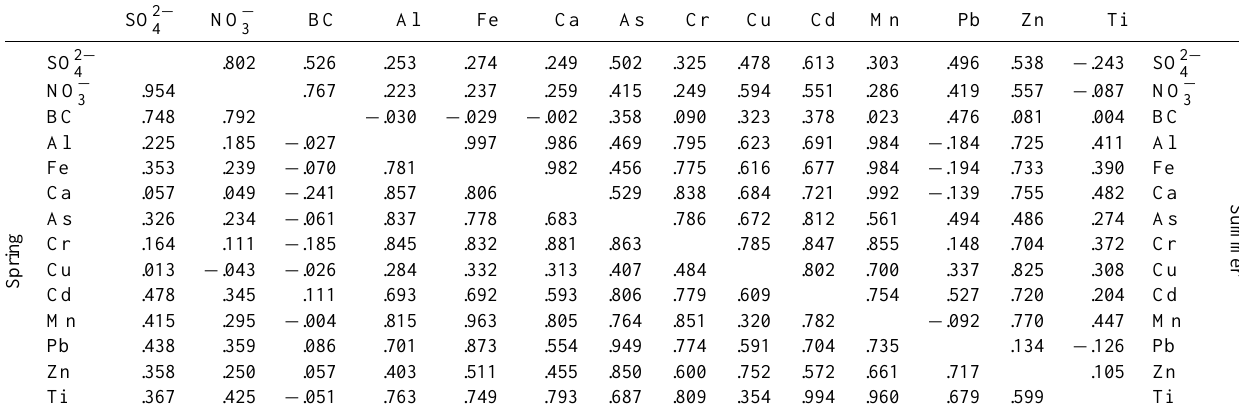
Table 11. Correlation coefficients among the certain species in spring and summer at